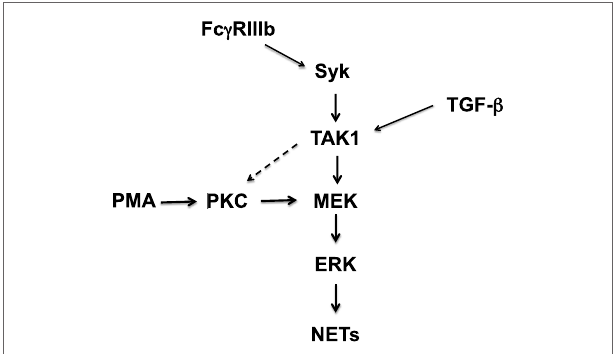
FigUre 9 | Model for signaling in neutrophils to induce neTosis . In human neutrophils, cross-linking Fc γ RIIIb leads to activation of spleen tyrosine kinase (Syk) and transforming growth factor- β -activated kinase 1 (TAK1). TAK1 is then required for activation of ERK kinase (MEK) and extracellular signal- regulated kinase (ERK). Activated ERK contributes to the formation of neutrophil extracellular traps (NETs). Phorbol 12-myristate 13-acetate (PMA) can directly activate protein kinase C (PKC), which in turn leads to activation of the MEK/ ERK pathway. These kinases finally promote NET formation. Fc γ RIIIb-induced NET formation also depends on PKC (15). Thus, TAK1 might also be able to activate PKC (dashed arrow), but this remains to be demonstrated. Transforming growth factor- β (TGF- β ) is a potent activator of TAK1. However, this activation does not seem to have any effect of NET formation induced by PMA or Fc γ